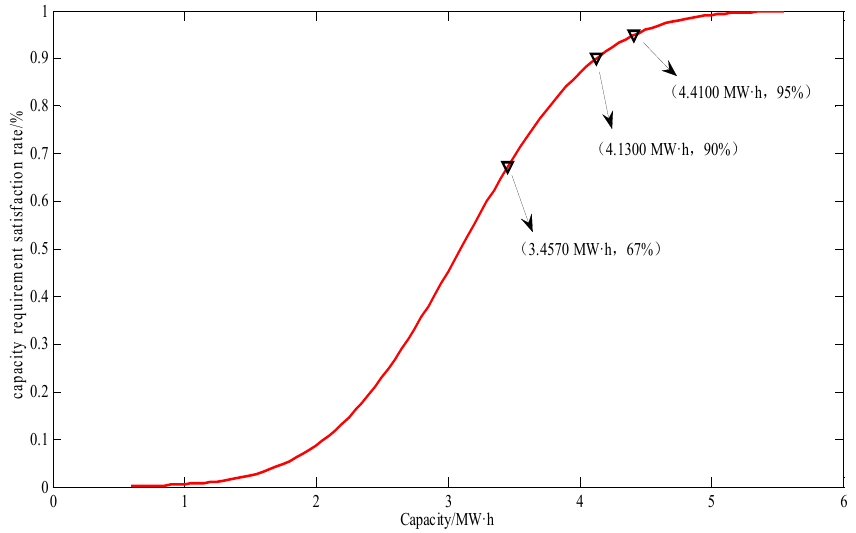
Figure 10. The relationship between annual storage capacity and capacity demand satisfaction rate.